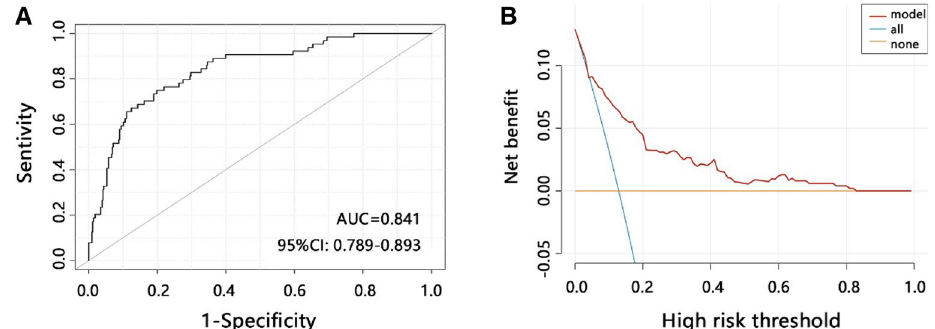
Figure 4. Development of the comprehensive model and its performance on death risk in individuals with positive QFT-GIT. ( A ) ROC curve analysis was used to predict death. ( B ) Decision curve analysis (DCA) was used to assess the clinical usefulness. The x-axis indicates the threshold probability. The y-axis indicates the net benefit.